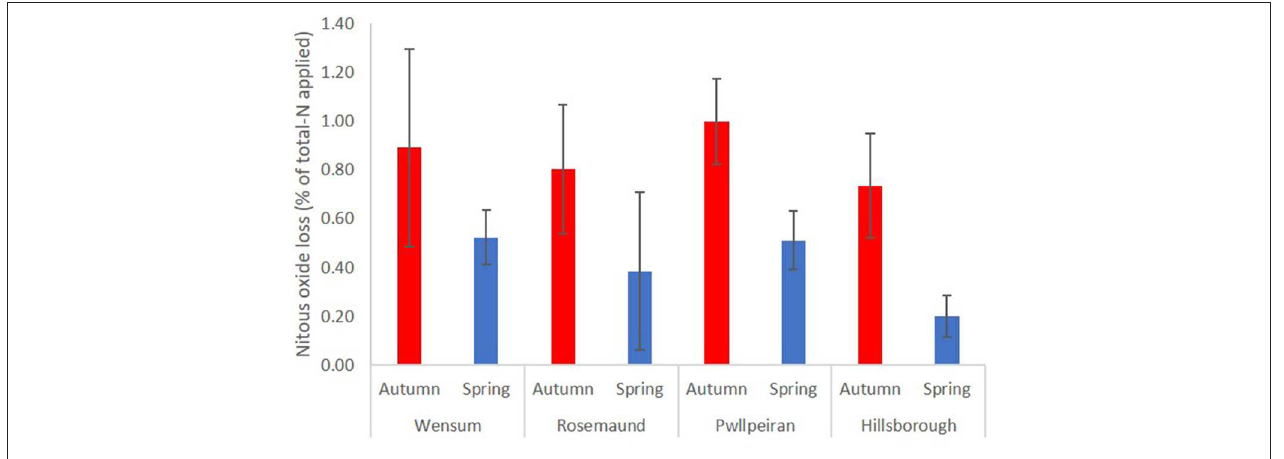
TABLE 11 | The effect of DCD on N 2 O EFs (% total N applied) from slurry application at the grassland sites. Application timing With DCD Without DCD Significance SED Autumn 0.55 0.78 P = 0.328 0.25 Spring 0.22 a 0.40 b P = 0.039